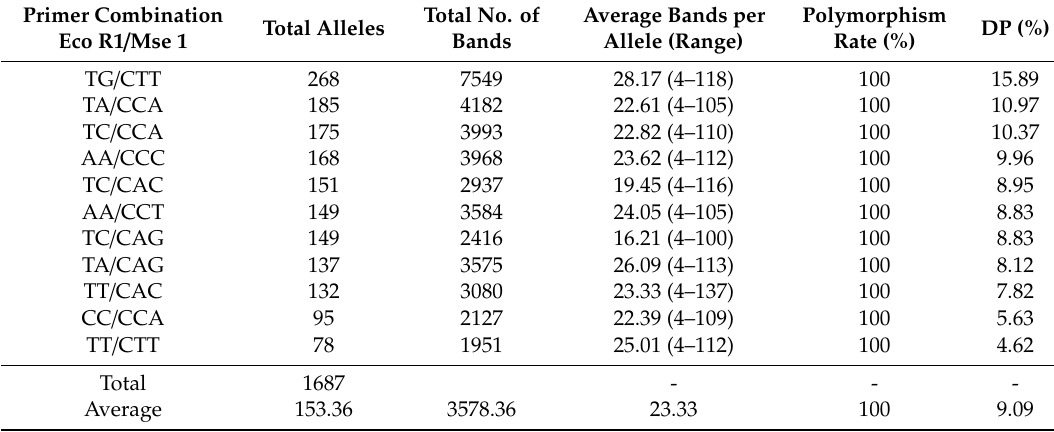
Table 1. Characteristics of 11 amplified fragment length polymorphism (AFLP) primers selected from 120